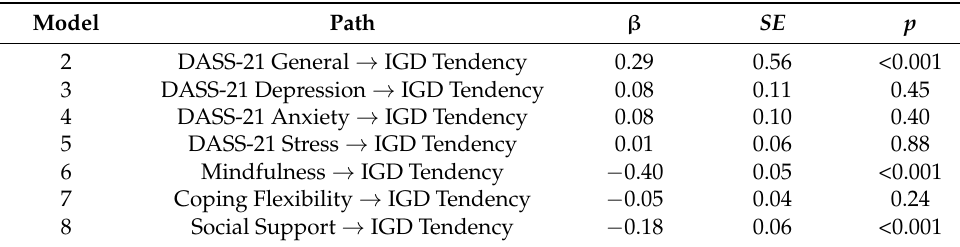
Table 2. Univariate latent regression models of IGD tendency across both sexes and two countries (Models 2 to 8).